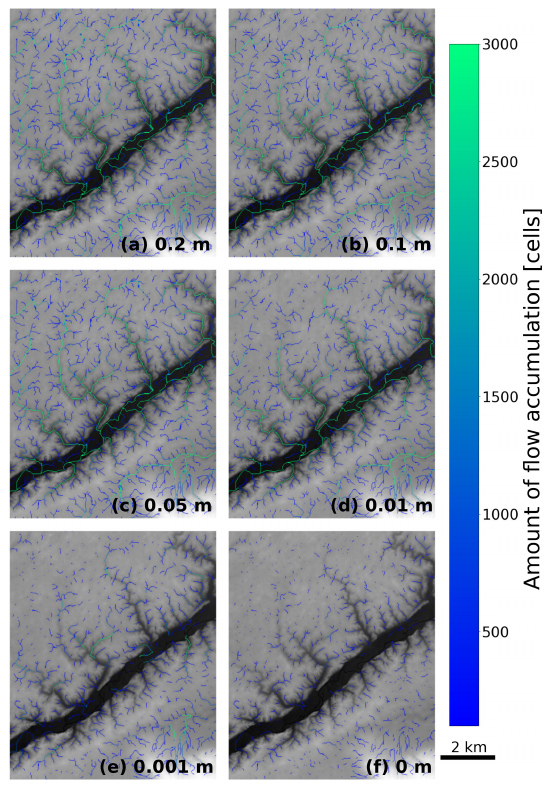
Figure 6. Drainage networks on partially filled landscapes at the Sangamon River site. Flow networks were created using the FlowAccumulation method included in RichDEM (Barnes et al., 2014a; Barnes, 2016) with the result masked to show only cells with a flow accumulation greater than 100. Hydrologic connec- tivity changes depending on how many depressions remain in the landscape. The unfilled depressions associated with each panel are shown in Fig. 5. The colours indicate the amount of flow accumu- lation in stream channels. Higher runoff depths applied to Flow- Fill fill more depressions and result in higher degrees of hydro- logic connectivity. In (a) , with 0.2m of runoff, all depressions were filled: drainage is fully integrated, and the result is identical to that for a flow-routing surface created using standard flood-fill tech- niques (e.g. Barnes et al., 2014a; Barnes, 2016). In (b–e) , decreas- ing amounts of starting runoff result in increasing segmentation of the stream network. Panel (f) shows the original DEM, which hosts only a few disconnected stream segments.